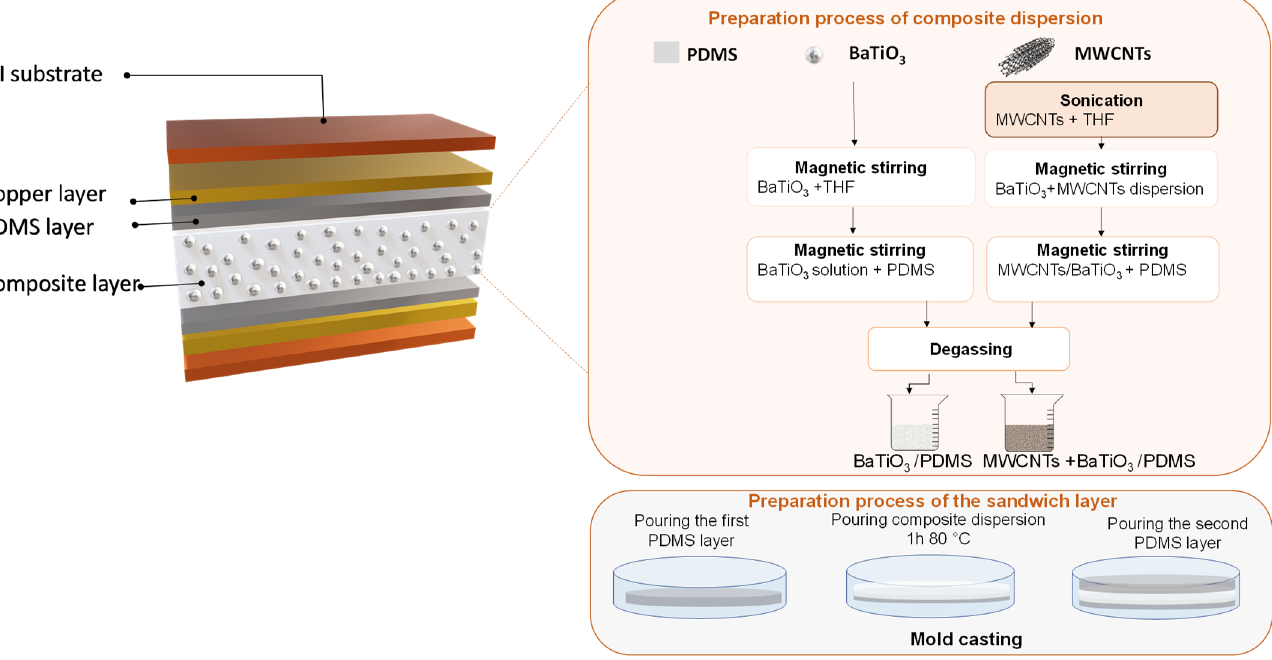
Figure 1. Flowchart of the fabrication process of different types of nanocomposites with an illustration about the structure of the final nanogenerator.